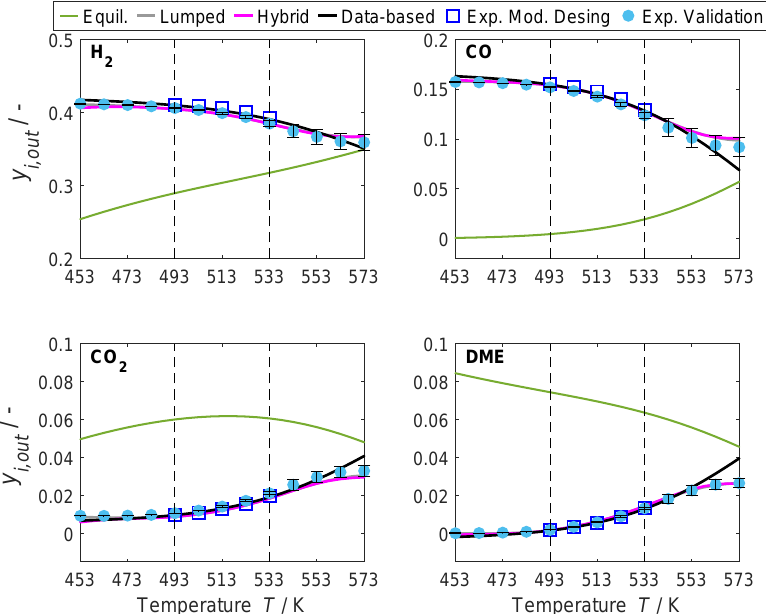
Figure 12. Evaluation of range extrapolation by comparison of models’ predictions and experimental results beyond the models’ validity range for temperature. Feed composition: 42.3% H 0.82% CO . Total gas flow 0.6 slpm. Pressure 50 bar. CZA-to- γ -Al 2 26 HNs. Predictions of the lumped and hybrid model overlap over the entire temperature